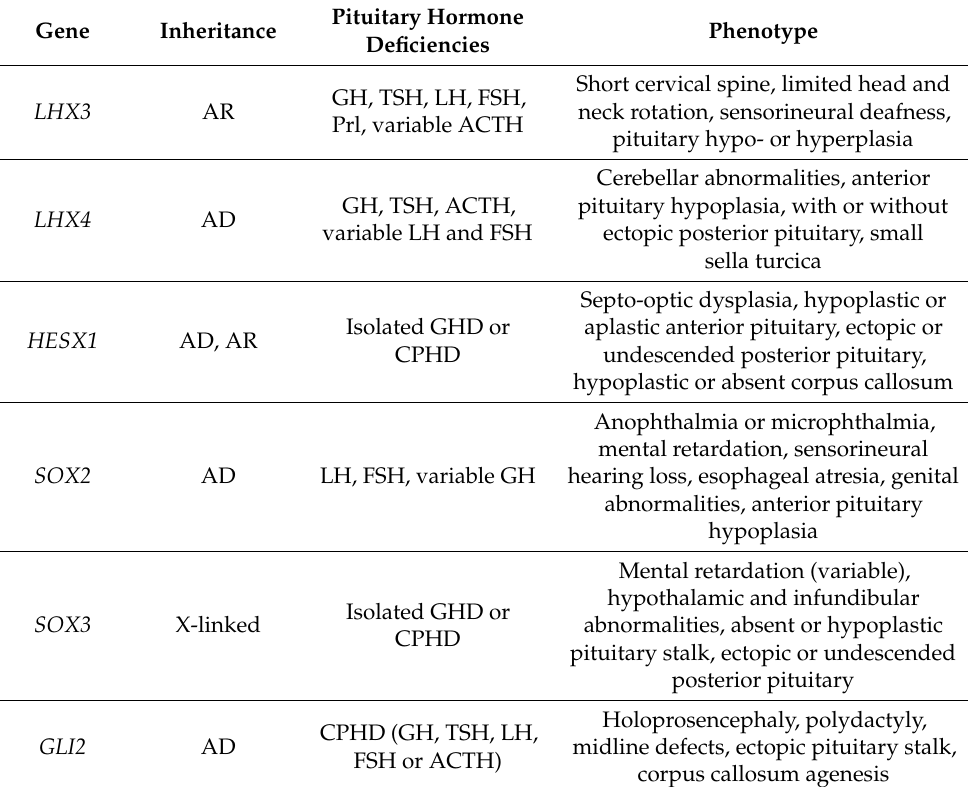
Table 2. Genetic disorders in syndromic combined pituitary hormone deficiency (only the syndromes involving GHD are included)